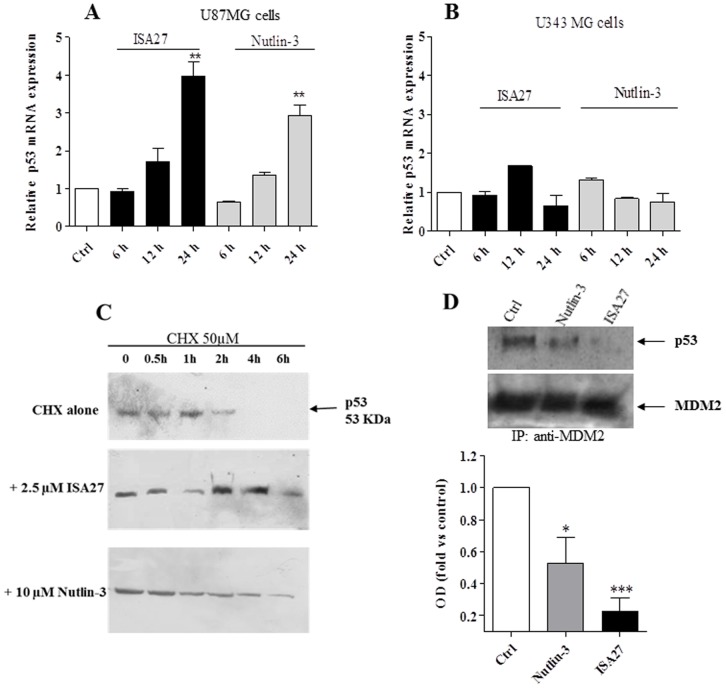
ISA27 induces the stabilisation of p53 protein levels by decreasing the interaction of p53 with MDM2 in GBM cells.
A and B) Effect of ISA27 on p53 gene expression: U87MG and U343MG cells were treated with ISA27 or Nutlin-3 for 6, 12 and 24 h. After incubation, the relative quantification of p53 mRNA was performed by real-time RT-PCR. In U87MG cells, p53 mRNA levels did not change within 12 h of cell treatment; in U343 MG cells, p53 mRNA levels did not change during any of the incubation times. 3C) ISA27 sustains p53 protein expression in the presence of CHX: U87MG cells were incubated with 50 µM CHX alone or CHX in combination with ISA27 or Nutlin-3 for 0.5, 1, 2, 4 and 6 h. After incubation, cell lysates were used for Western blot analysis. One representative Western blot is presented for each cell treatment. The inhibition of protein synthesis by treatment with CHX alone blocked p53 protein expression after a 4-h treatment. ISA27 extended the stability of p53 in the presence of CHX. 3D) ISA27 reduces MDM2-p53 complex formation: U87MG cells were incubated with ISA27 or Nutlin-3 for 8 h followed by immunoprecipitation using an anti-MDM2 antibody. The MDM2-p53 complex and the relative input of the proteins were detected by immunoblot; a significant reduction in MDM2-p53 complex formation was shown in U87MG cells following 8 h of treatment with ISA27.